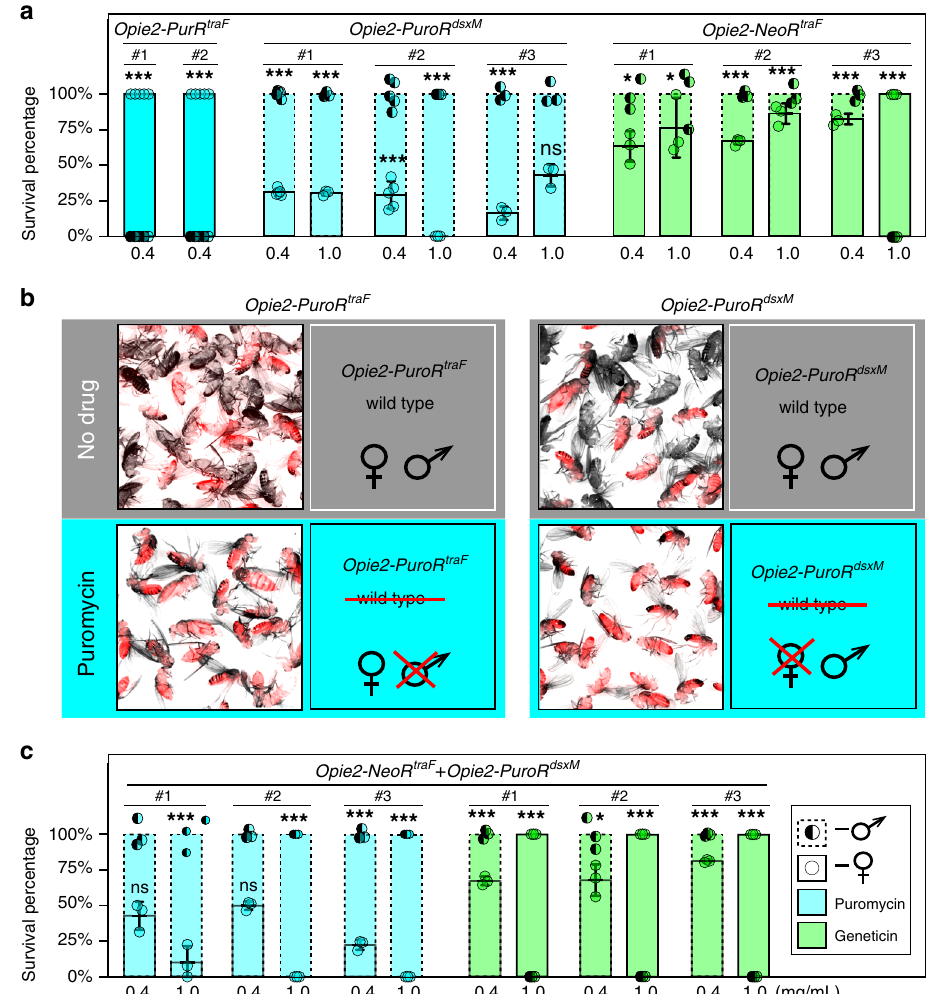
Fig. 2 Positive selection of a speci fi c sex. Sex-speci fi c drug resistance is achieved by inserting the female-speci fi c traF or male-speci fi c dsxM intron into the coding sequences of PuroR and NeoR . a The ef fi ciency of drug-induced sex sorting was assessed for a few independent transgenic lines of the same genetic construct. Transgenic fl ies harboring one copy of the antibiotic-resistance genes were raised on drug-supplemented food. When sex sorting was not 100% ef fi cient, the higher drug concetration of 1.0 mg/ml was used. b Expression of Opie2-PuroR dsxM or Opie2-PuroR traF transgene rescues only transgenic males or females (red fl uorescence) raised on the food supplemented with puromycin, while all wildtype (wt) fl ies (no red fl uorescence) and the transgenic fl